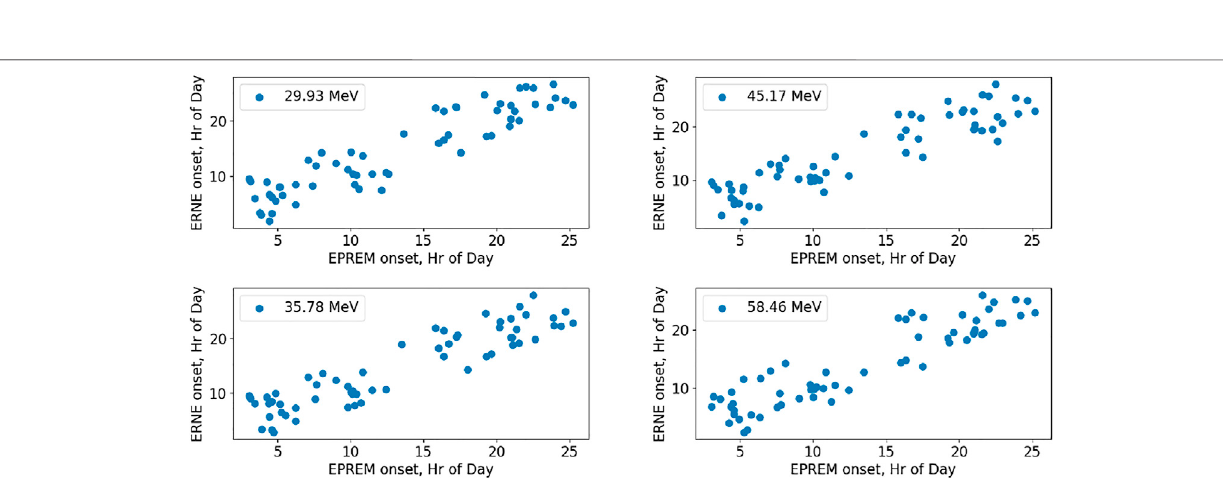
Frontiers in Astronomy and Space Sciences |